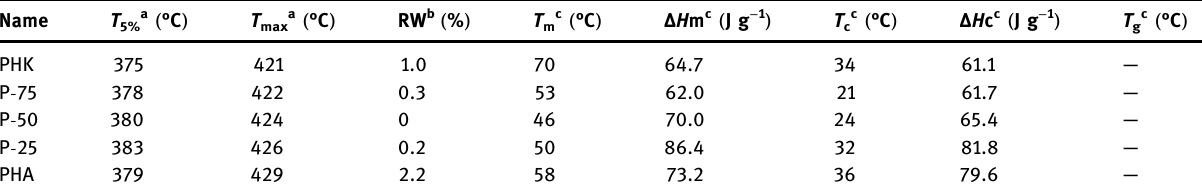
Table 2: Thermal characterization of PHK, PHA, and poly ( HK - co - HA ) copolymers